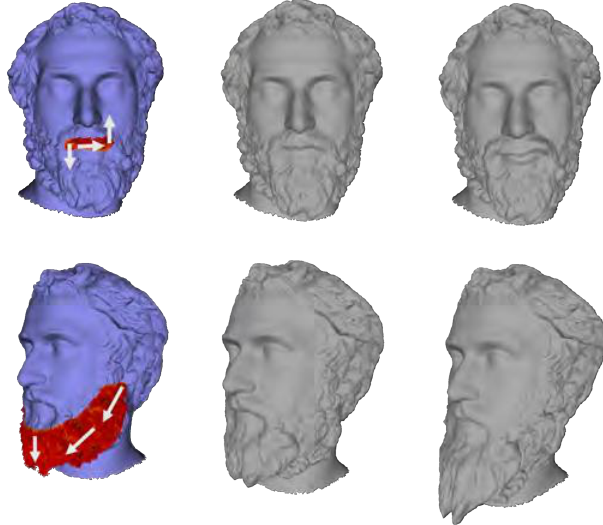
Fig. 10 Top: the vector field (left) is bent along the lips to cause the Roman bust (middle) to smile (right). Bottom: the beard is elongated along a vector field on the